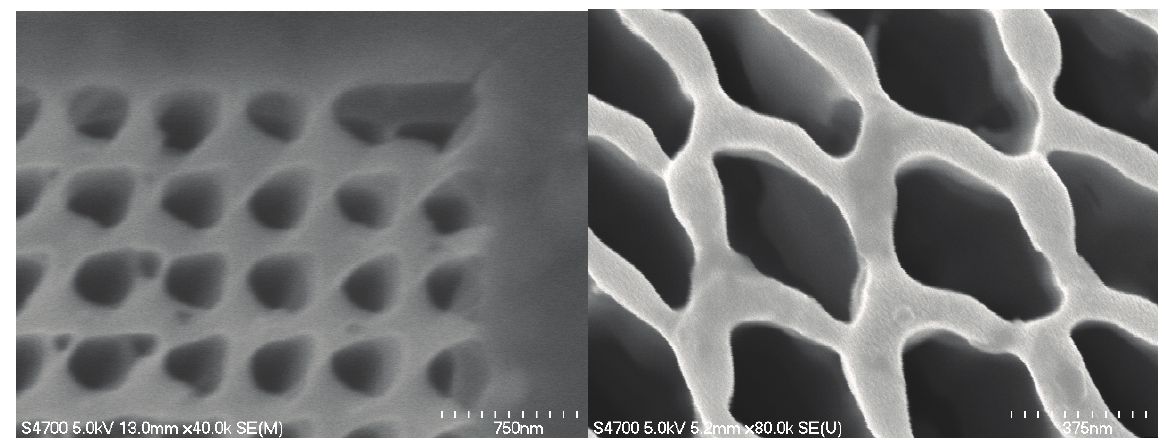
Figure 1. Electrodeposited PM patterned by FIB